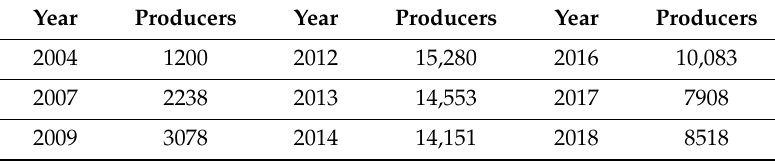
Table 4. Evolution of the number of producers in organic agriculture in